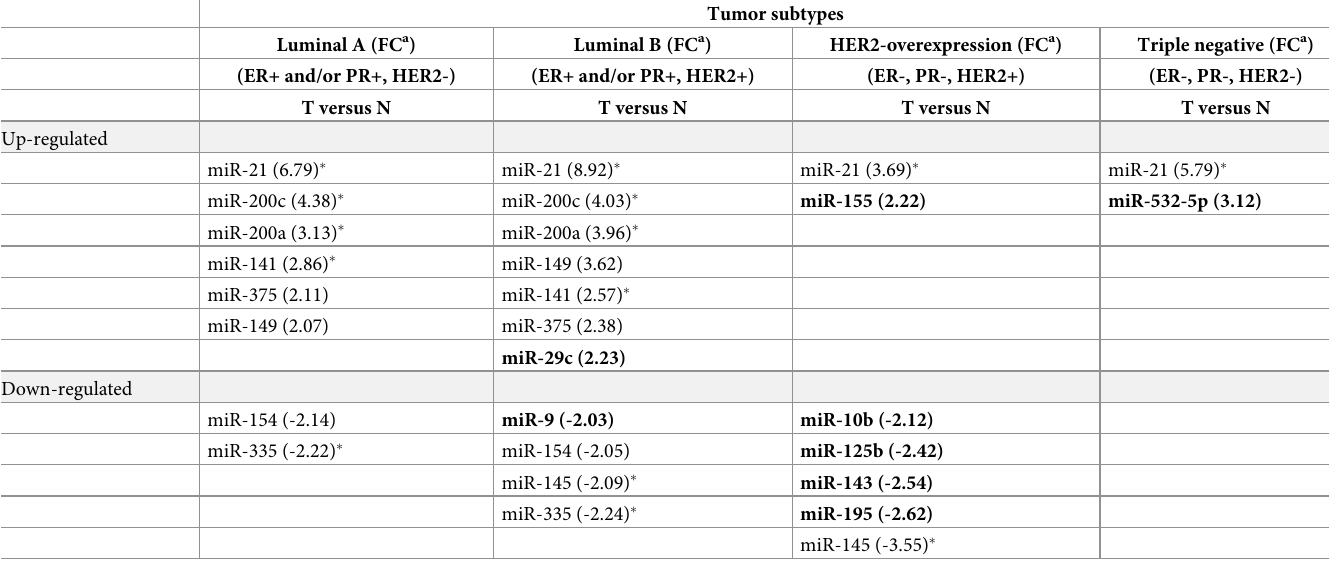
Table 8. Differential expression of miRNAs in specific tumor